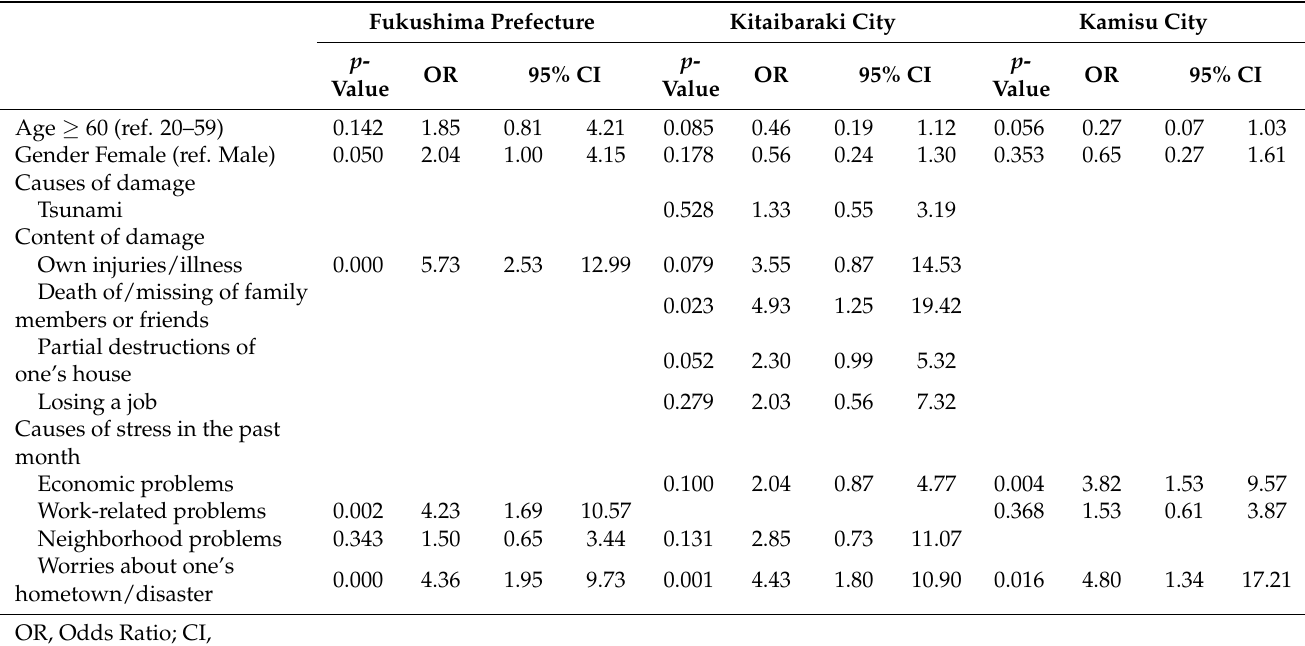
Table 4. Logistic regression analysis of characteristics of the participants and depression as severe psychological